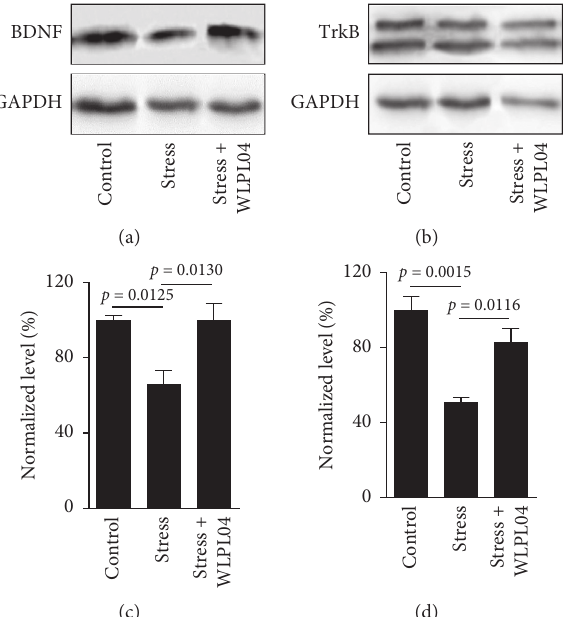
Figure 5: Protein levels of brain-derived neurotrophic factor (BDNF) and tropomyosin receptor kinase B (TrkB) in the mPFC of mice. Chronic stress reduces the expressions of (a), (c) BDNF and (b), (d) TrkB, and such effects are rescued by the L . plantarum WLPL04 treatment. Three independent experiments were conducted in each sample